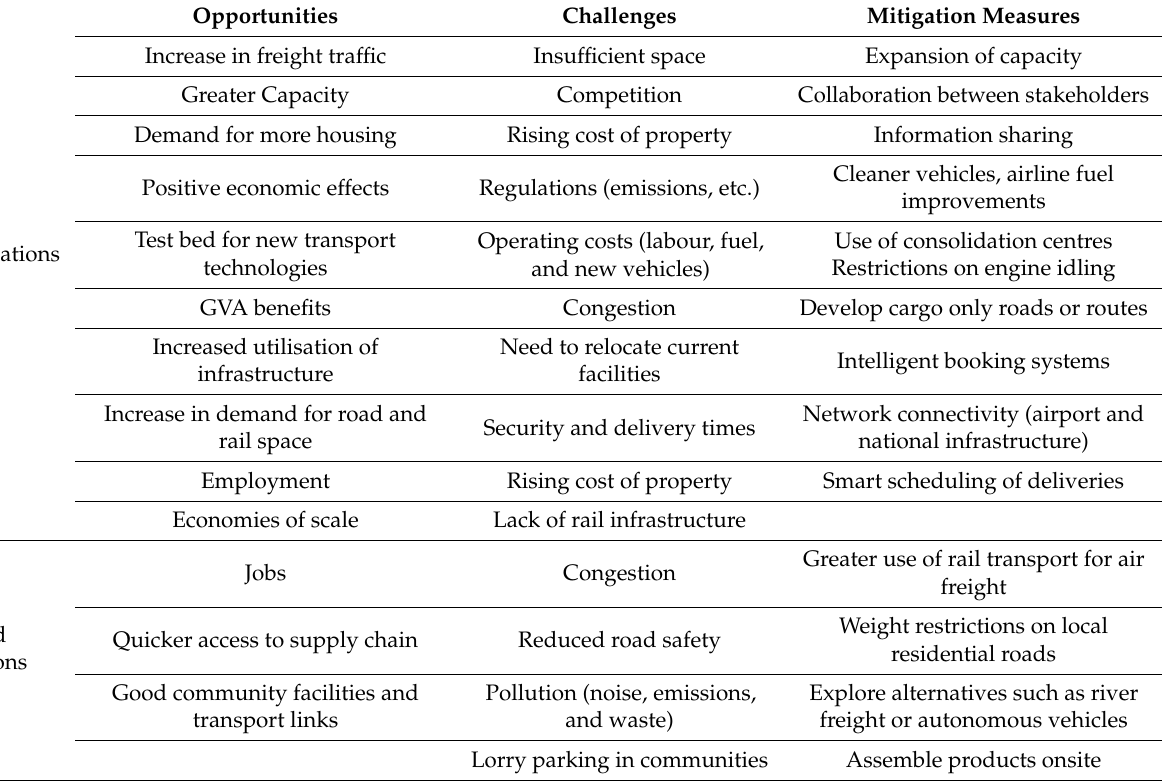
Table 4. Breakdown of implications and possible mitigation measures (Source: The authors based on data analysis). Opportunities